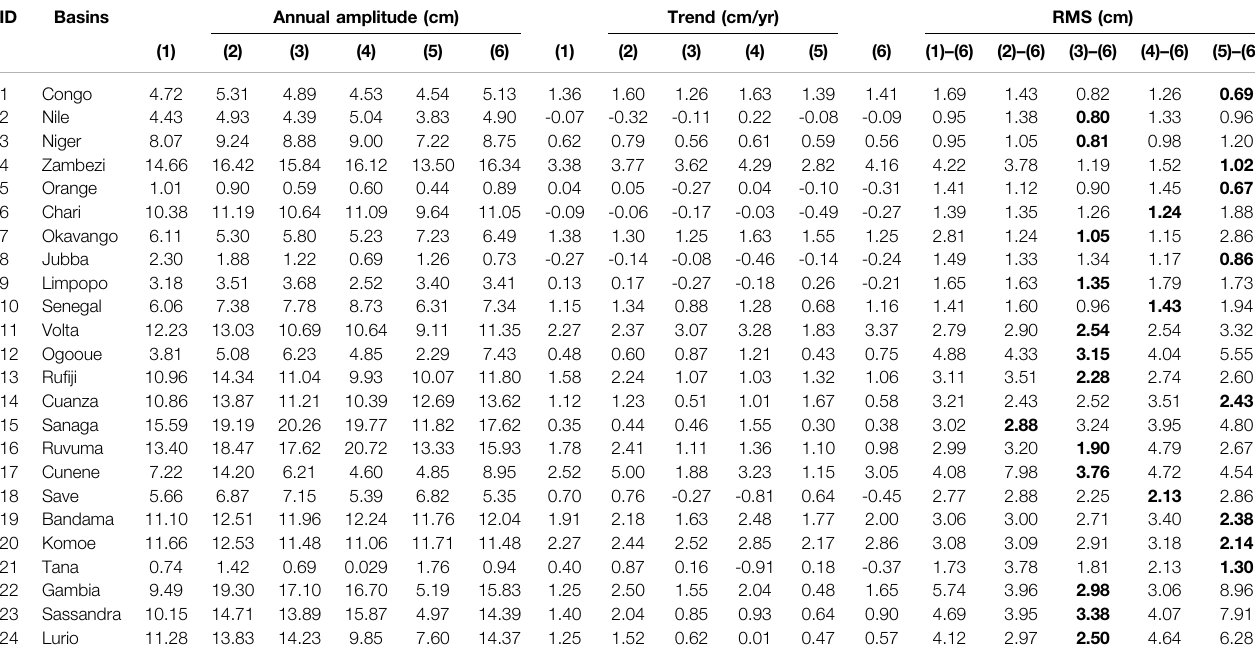
TABLE 5 | Annual amplitudes (cm), trend (cm/yr), and RMS (cm) of 24 river basins over Africa derived from different solutions: (1) CSR Tellus Mass Grid without scale factor, (2) CSR Tellus Mass Grid with scale factor, (3) CSR mascon solution, (4) JPL mascon solution, (5) general forward modeling method, (6) improved forward modeling method a .